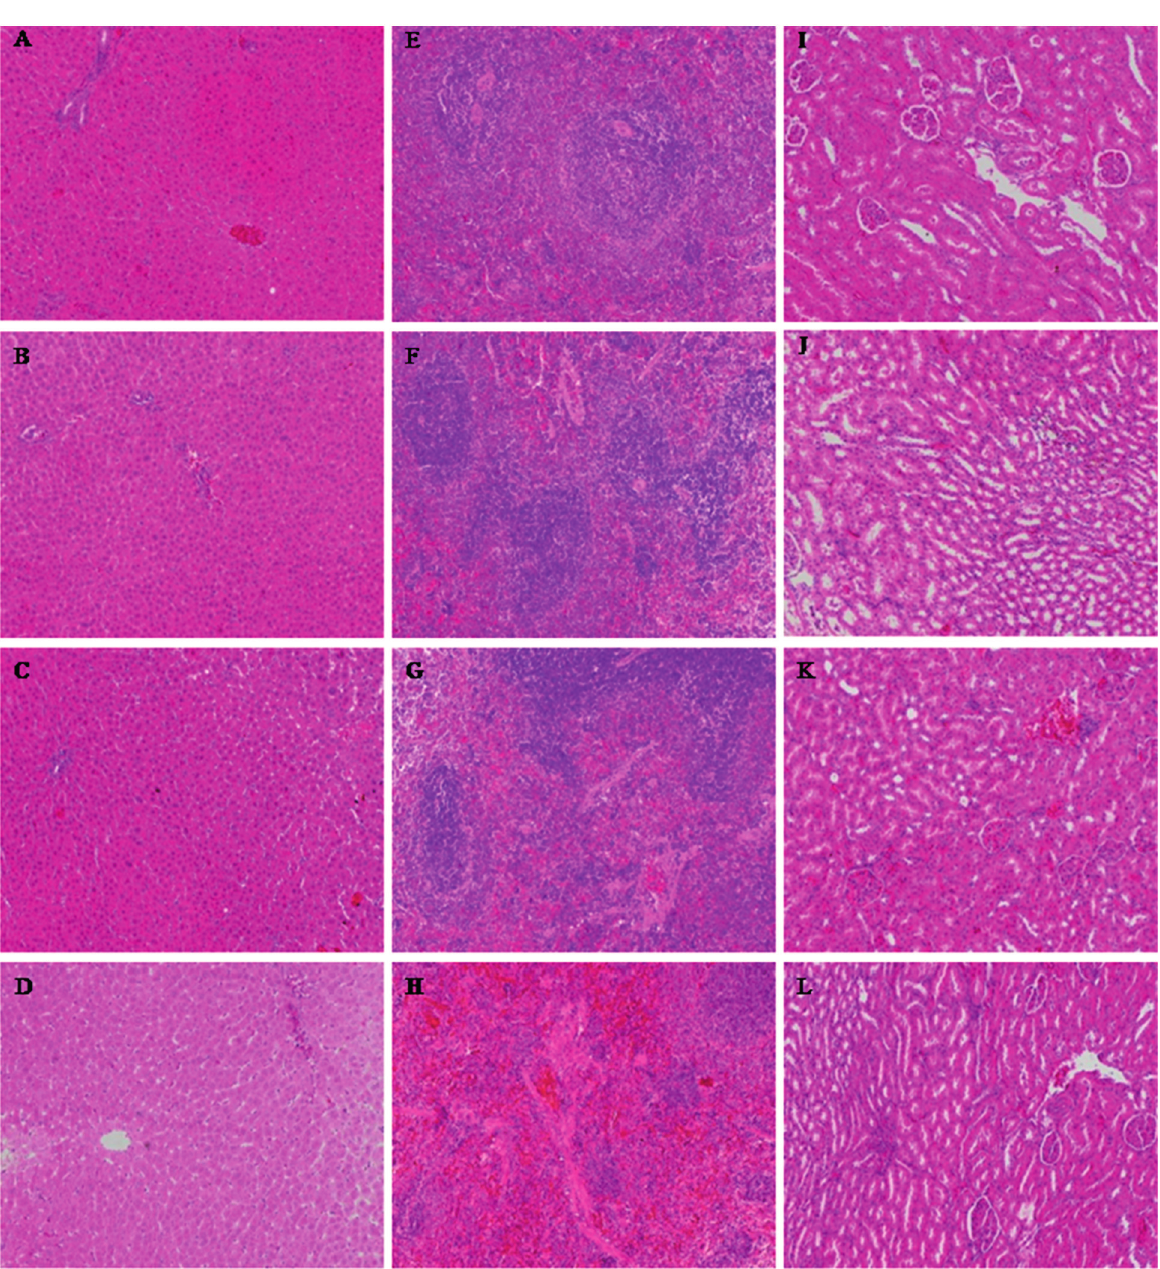
Figure 3. The results of the histopathological examinations of rats orally administered ATTM for 28 days (H&E × 100). ( A – D ) liver; ( E – H ) spleen; ( I – L ) kidney. ( A , E and I ) control group; ( B , F and J ) low-dose group; ( C , G and K ) middle-dose group; ( D , H and L ) high-dose